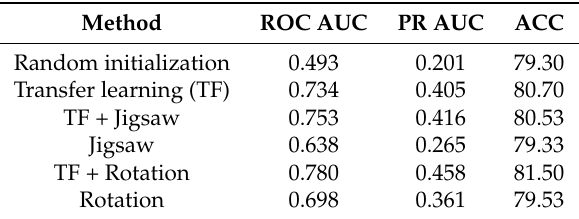
Table 4. Training on 200 images (10% of the training